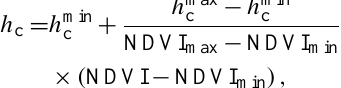
ing the Stefan–Boltzmann equation (Brutsaert, 2005). Atmo- spheric pressure data, which are absent from many towers, were calculated based on ground elevation of tower locations using an equation presented in Bos et al. (2008). Canopy height ( h c ), which is needed for the SEBS model, was ob- tained from tower metadata and was assumed constant during the simulation period. Although h c varies over many vegeta- tion types, accounting for its within- and inter-annual vari- ability is usually not possible, as observed data of h c vari- ations are rarely recorded. Tower data were aggregated (i.e. summed for precipitation and averaged for other input vari- ables) from their native resolution of half-hourly or hourly